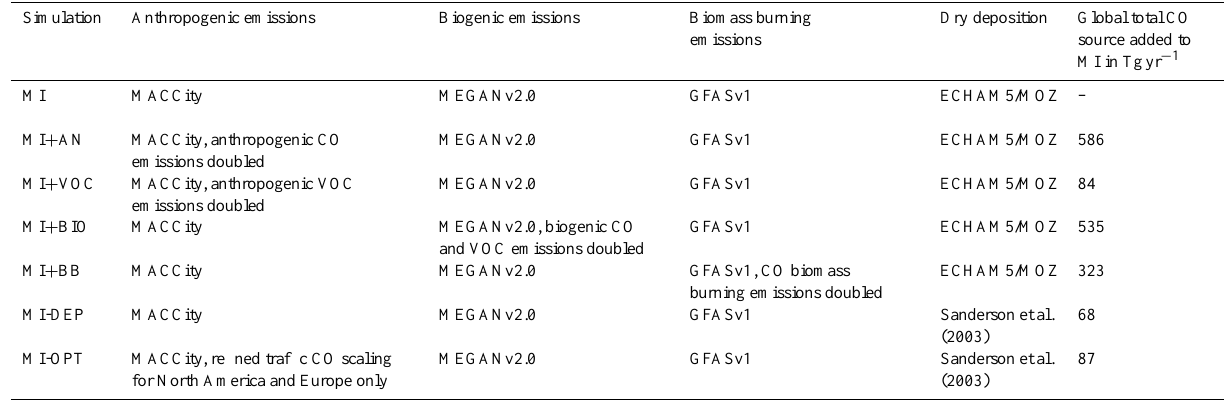
Table 3. Description of MOZART 2008 sensitivity simulations.